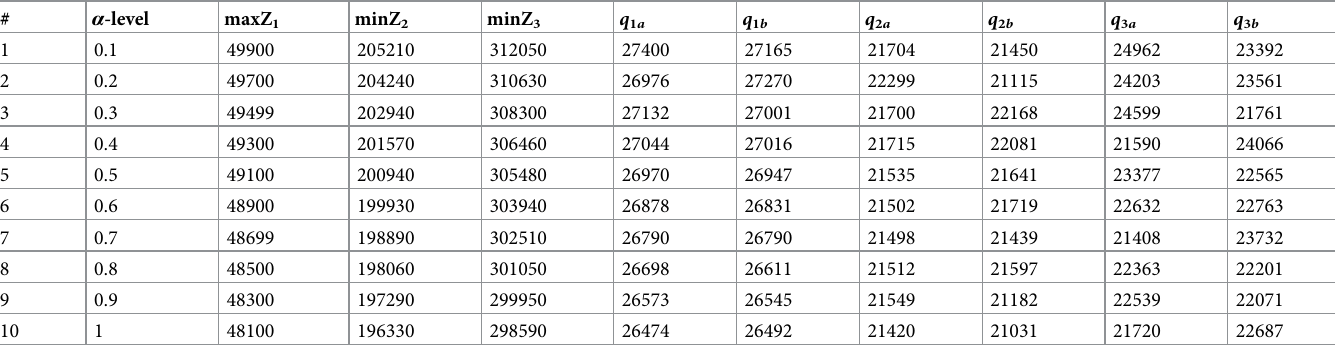
Table 14. Results for LP-Metrics